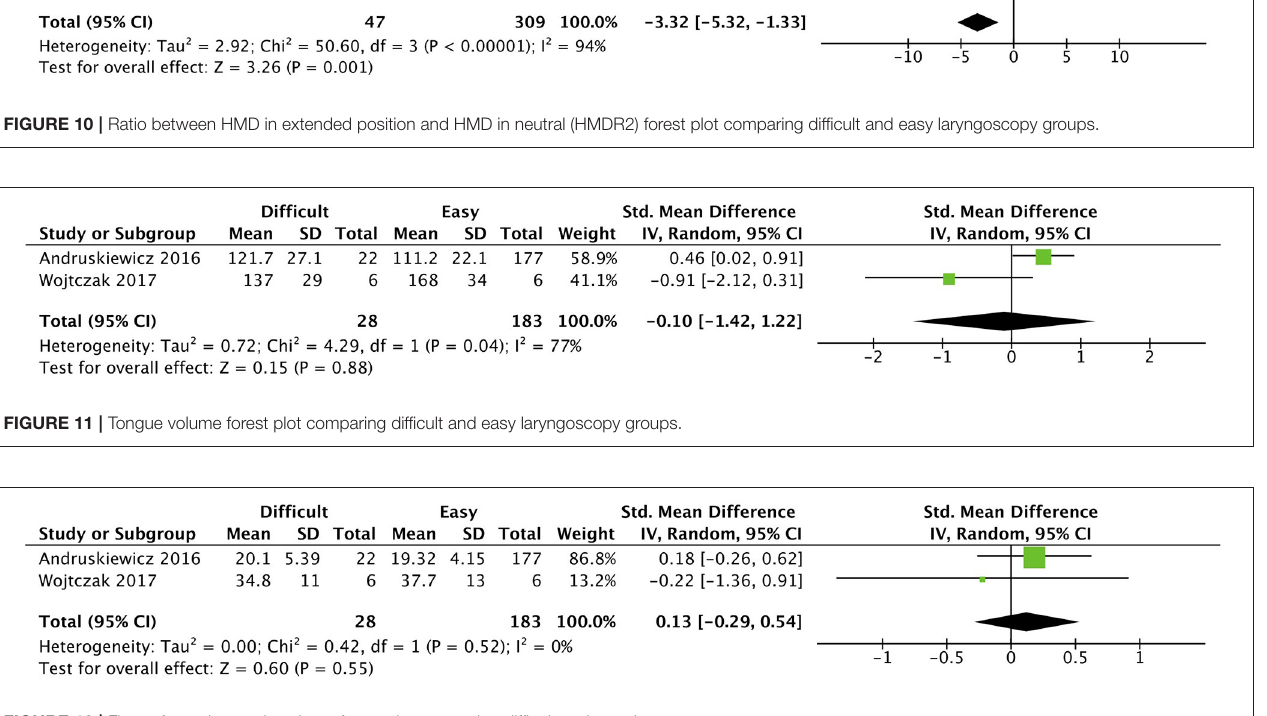
(Se: 63%, Sp: 66%) predicts a difficult laryngoscopy. By